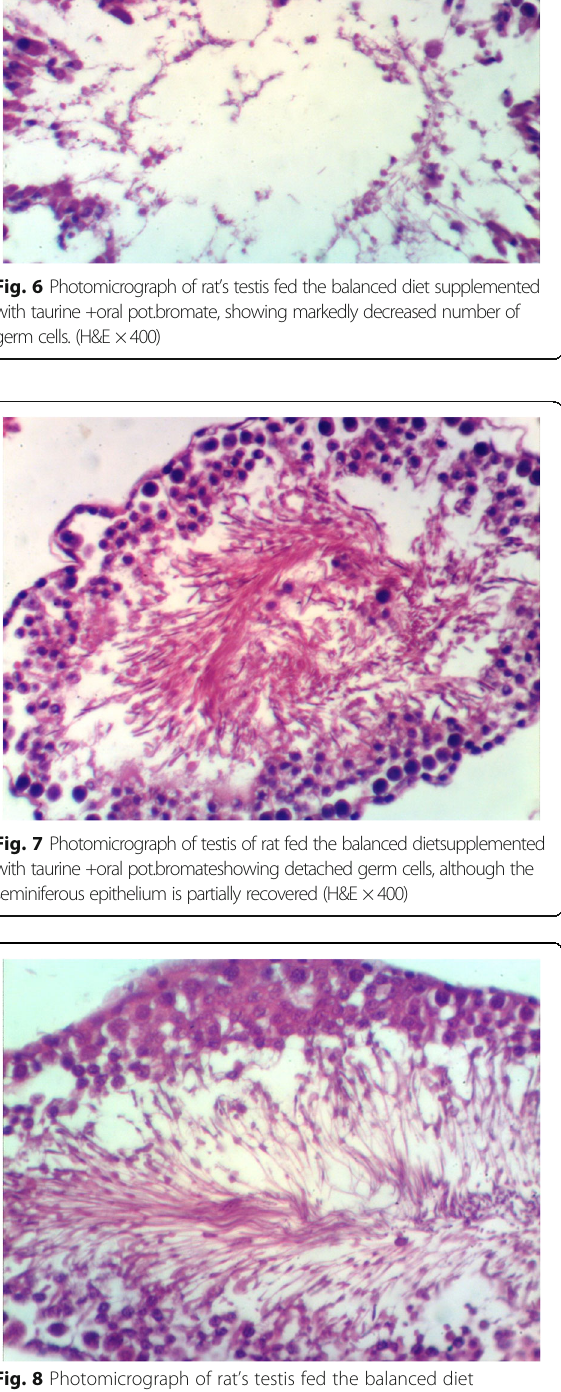
Fig. 5 Photomicrograph of normal control rats ,showing the normal histological structure of renal parenchyma (H&E × 400)